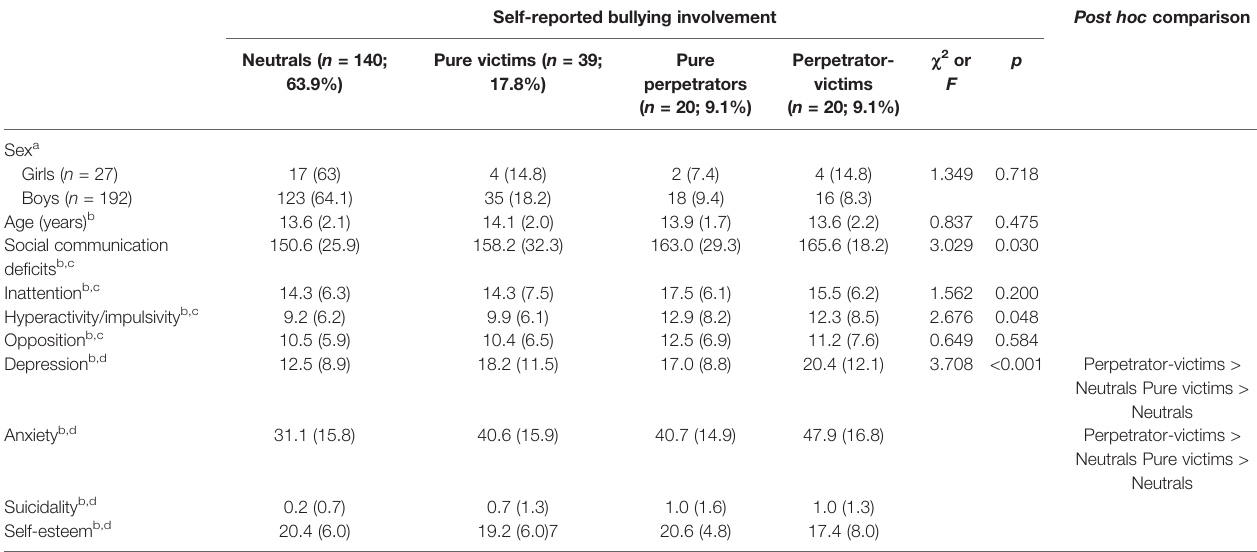
TABLE 2 | Sex, age, social communication de fi cits, inattention, hyperactivity/impulsivity, opposition, depression, anxiety, suicidality, and self-esteem among the groups of various self-reported bullying involvement ( N = 219).